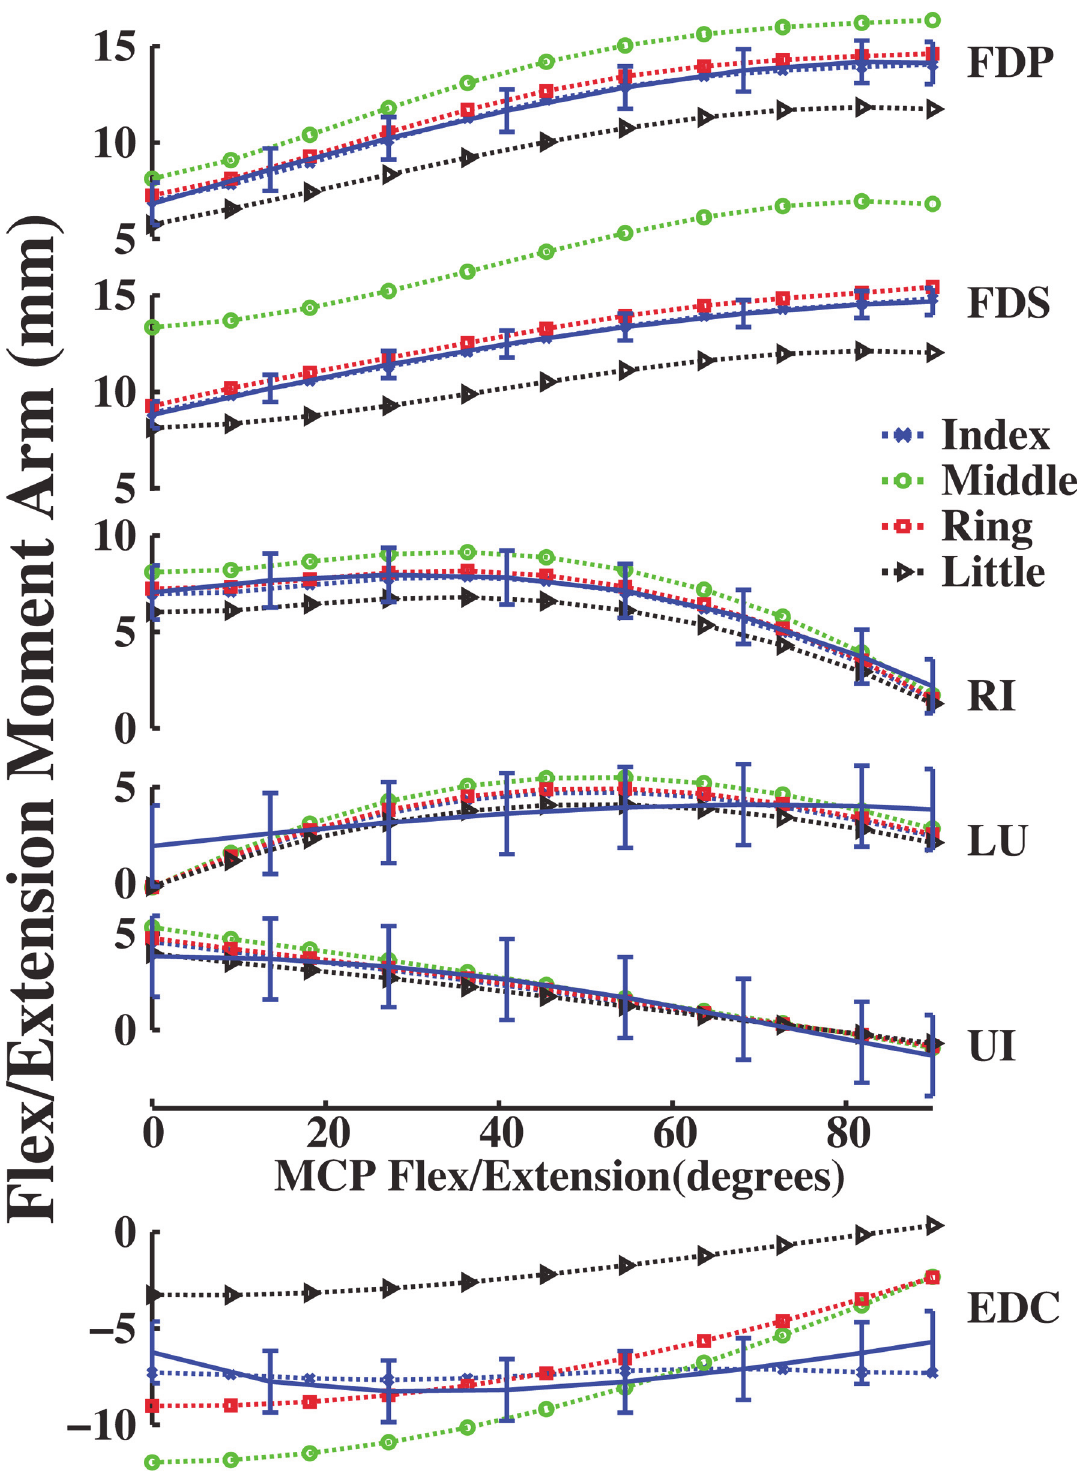
Fig 2. Flex/extension moment arms (mm) as a function of flexion (+)/ extension (-) at the MCP joint of the all fingers. Dotted moment arm values are derived from experimentally measured muscle attachments [5], and solid moment arm values are direct measurements (n = 7 specimens with mean and standard deviation; [20]). Positive values indicate flexion moment arms, negative values indicate extension moment arms, and 0° is full extension. Blue, green, red and cyan colors represent index, middle, ring and little finger moment arms, respectively.